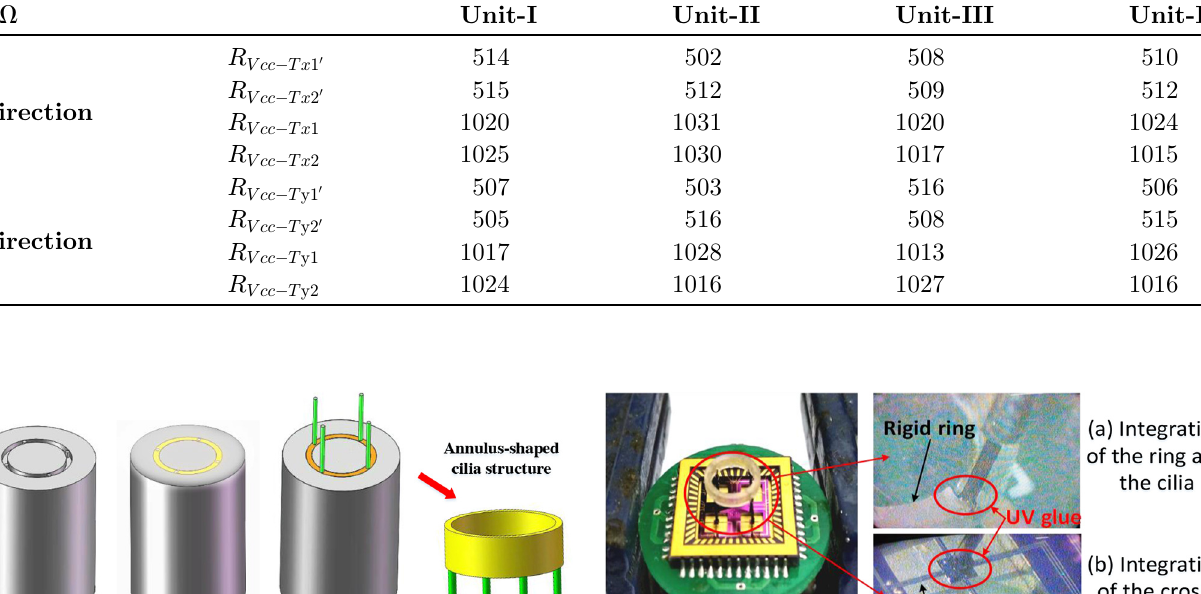
Table 4. Testing value of equivalent resistances. No. V